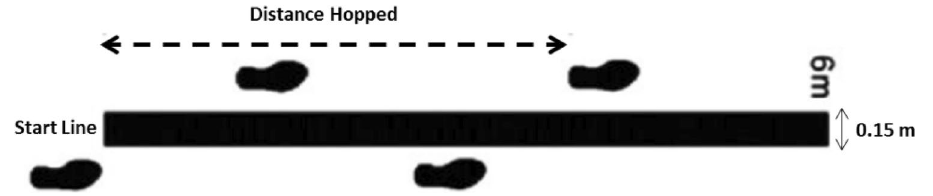
Figure 2. Set up for the crossover hop test.